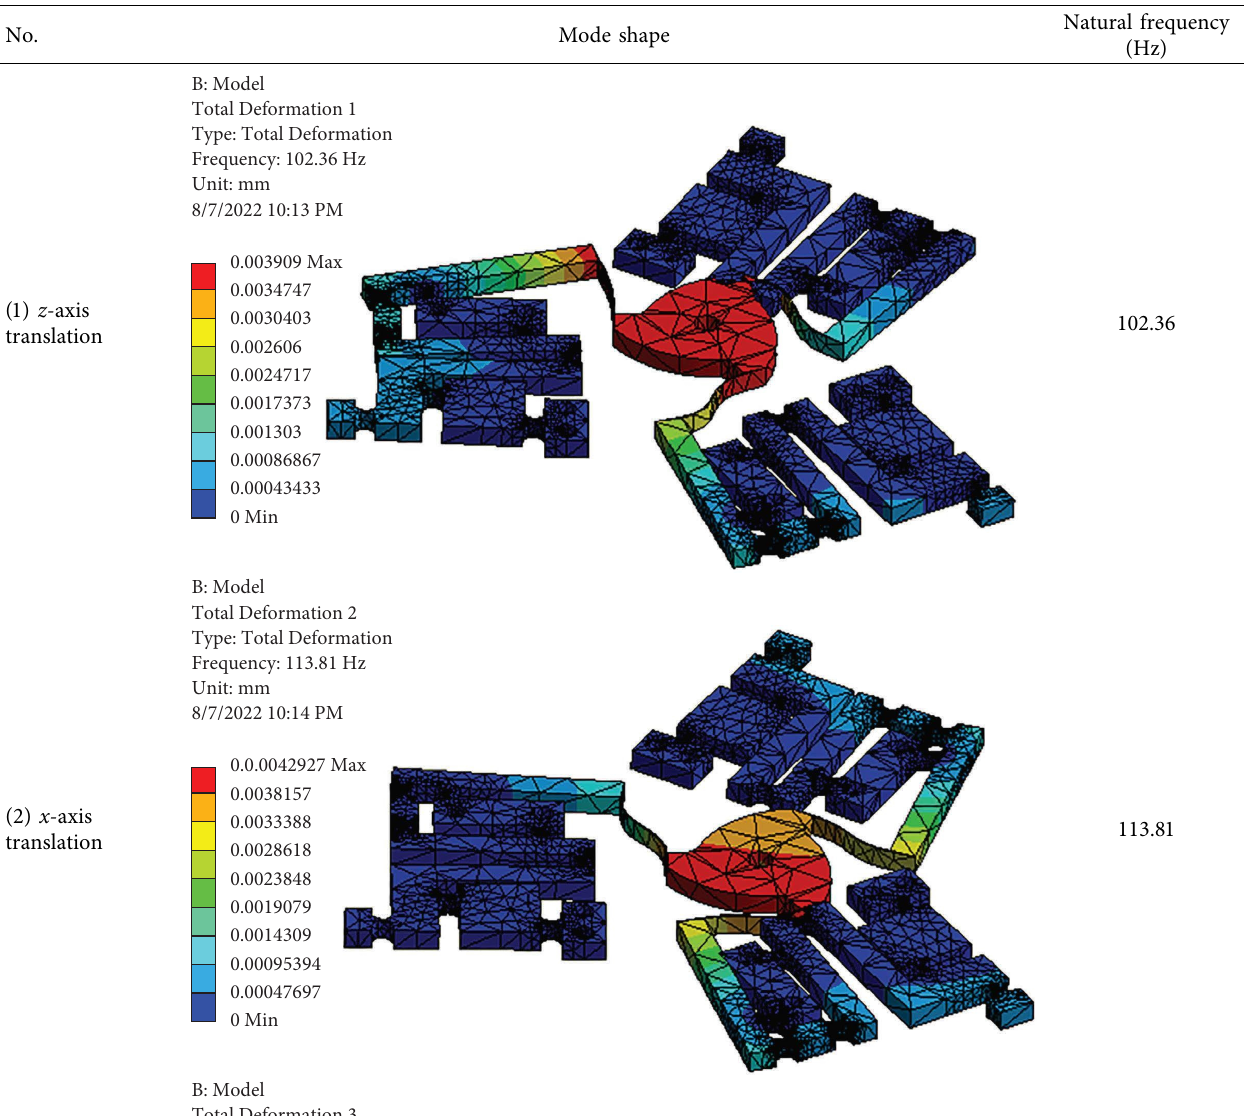
Table 4: Results of dynamic behavior with input displacement of 135 μ